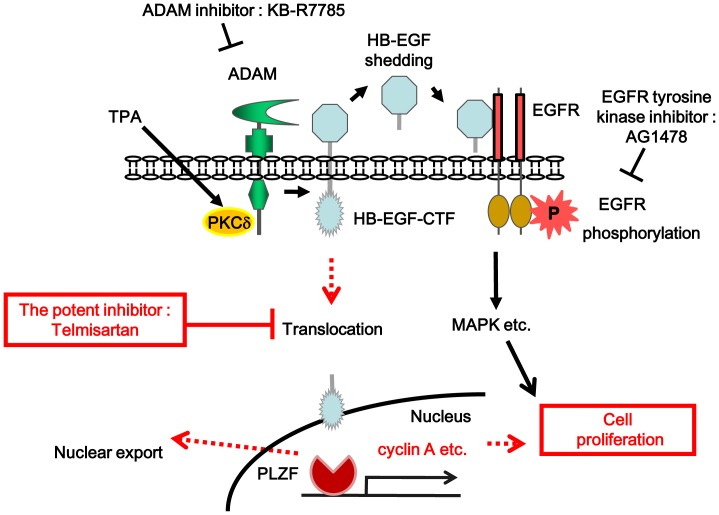
Dual signaling pathways of EGFR phosphorylation and HB-EGF C-terminal fragment nuclear translocation during cell proliferation.Quoted from [19] and modified. TPA induces an ADAM-mediated cleavage of proHB-EGF, and results in the ectodomain shedding of its N-terminal fragment and generation of an intracellular C-terminal fragment (CTF). The soluble HB-EGF binds to the EGFR and induces a rapid transient phosphorylation of EGFR. This phosphorylation results in the transcription of various genes. Meanwhile the HB-EGF-CTF is translocated into the nucleus, where it subsequently induces the nuclear export of PLZF. This results in the progression of cell cycle. The potent inhibitor blocks the nuclear translocation of HB-EGF-CTF. P indicates phosphorylation. Abbreviations: EGFR; epidermal growth factor receptor, TPA; 12-O-tetradecanoylphorbol-13-acetate, PKCδ; protein kinase Cδ, ADAM; a disintegrin and metalloproteinase, HB-EGF; heparin-binding EGF-like growth factor, CTF; C-terminal fragment, MAPK; mitogen-activated protein kinase, PLZF; promyelocytic leukemia zinc finger.